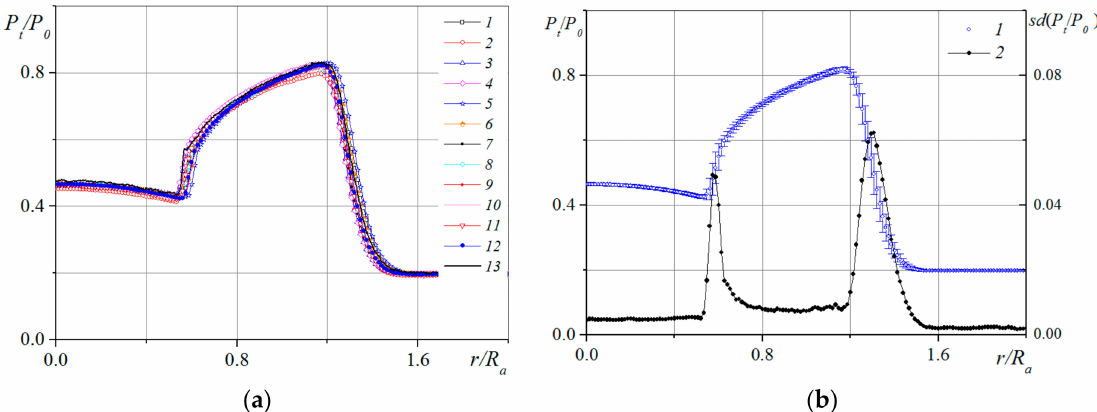
Figure 12. Radial distributions of pressure ( a ) and its root-mean-square deviations ( b ) in the cross-section of jet at x/R a = 2.0; ( a ) 1—the year of 2002, 2 and 3—2005, 4–6—2007, 7–11—2008, 12—2009, 13—vertical jet facility (VJF); ( b ) 1—average value of pressure and the confidence interval, 2—root-mean-square deviation of measured values from the mean